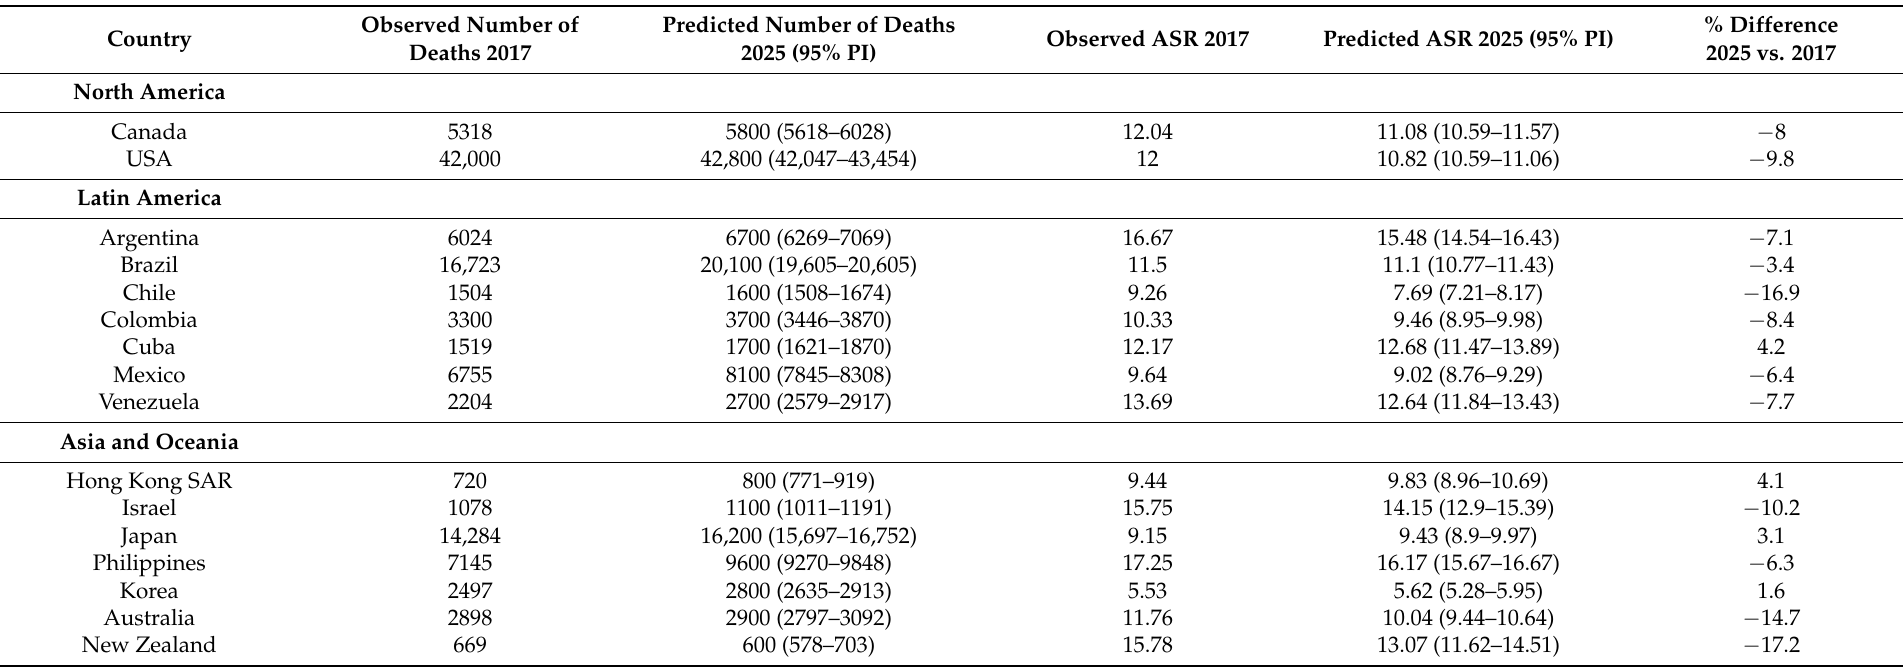
Table 4. Numbers of predicted deaths and age-standardized mortality rates (ASR) for the year 2025 and comparison figures for 2017 for the selected major countries from the Americas and Australasia, with 95% prediction intervals